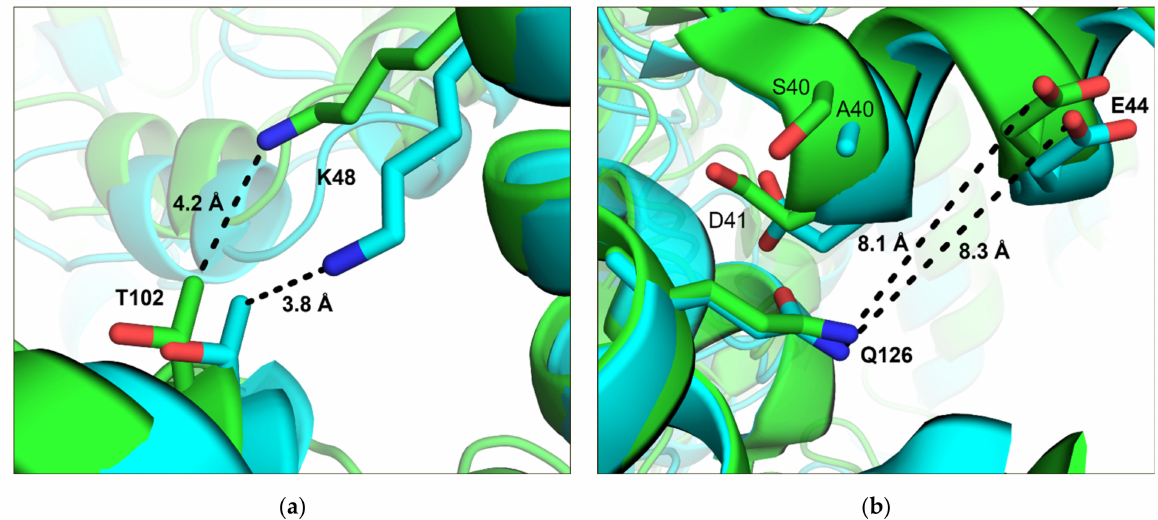
Figure 2. Illustration of Lk ADH (cyan) and Lb ADH (green) wild types’ intermolecular crystal contacts at amino acid position ( a ) T102 and ( b ) Q126. Figures were generated and distances were calculated using PyMOL (v.2.3;